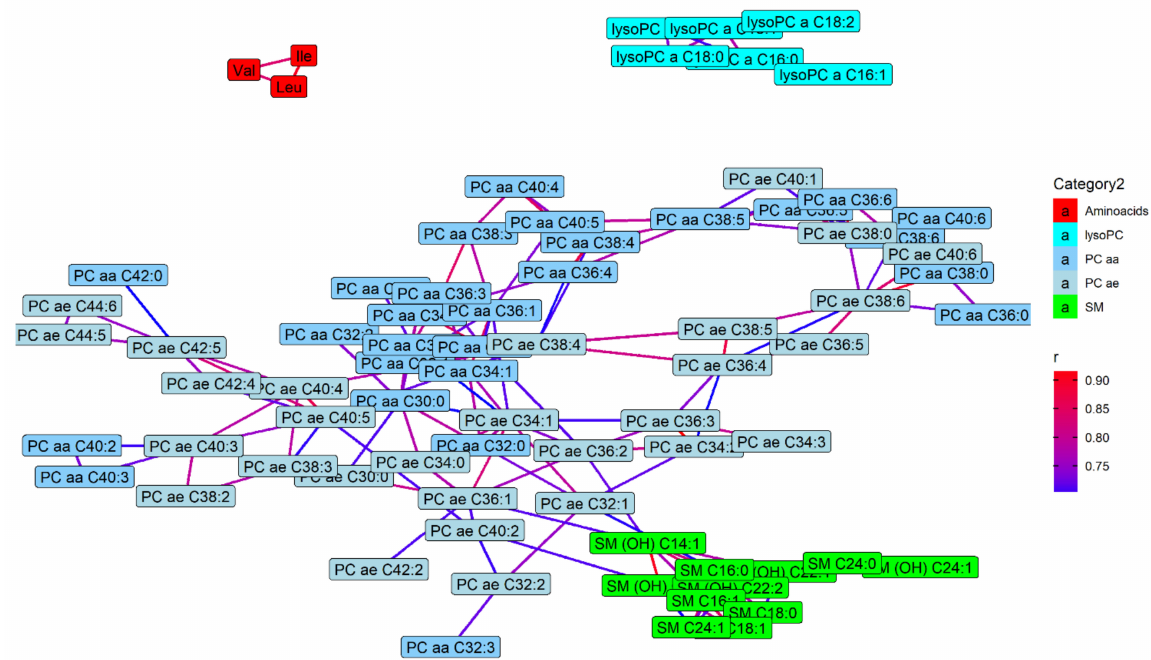
Figure 4. Network analysis performed considering metabolites as nodes and correlation coefficients (r) obtained from each pair of metabolites as edges. The Fruchterman–Reingold force-directed layout algorithm was used, and the edge weights were set on the value of r. Only statistically significant correlations with r > 0.7 were considered and metabolites with no connection were